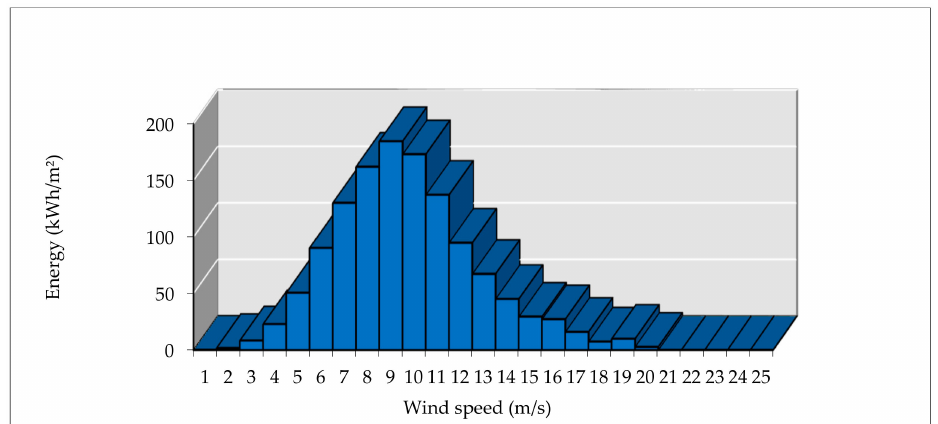
Figure 10. Energy distribution as a function of wind speed.